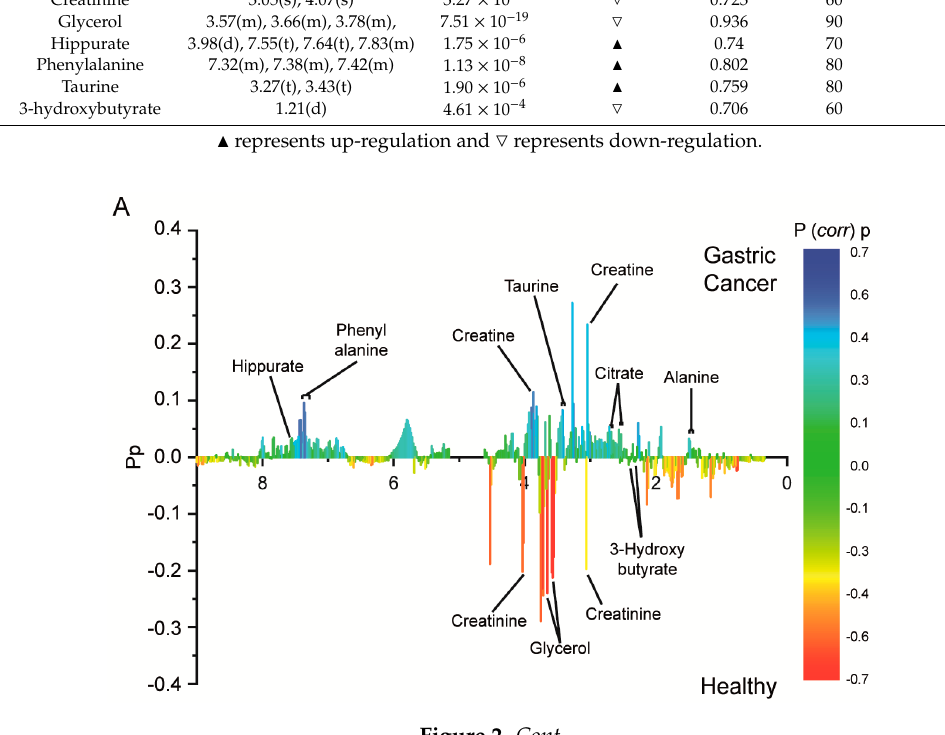
patients with gastric cancer. ( B ) Orthogonal projections to the orthogonal projection for a latent structure-discriminant analysis (OPLS-DA) score plot of the healthy control and gastric cancer groups. The model was constructed with one predictive ( P p ) and two orthogonal ( P o ) components. The overall goodness of fit and cross-validation coefficients are 86.5 and 72.8%, respectively. Black boxes: samples from healthy controls; red triangles: samples from